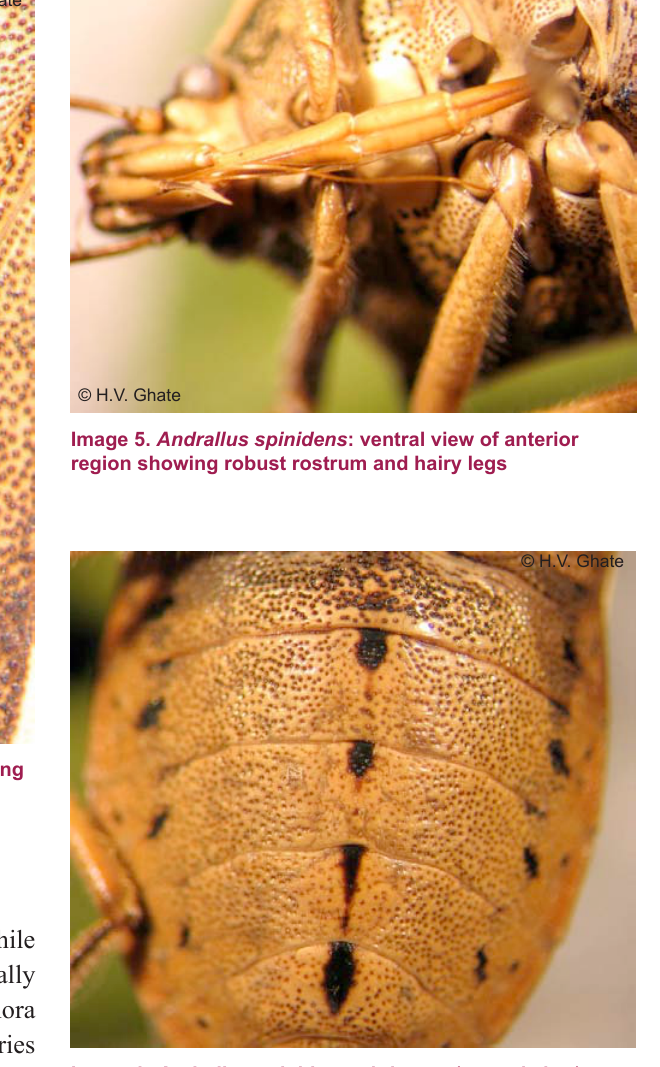
Image 6. Andrallus spinidens : abdomen (ventral view) showing characteristic pattern of black coloration and coarse